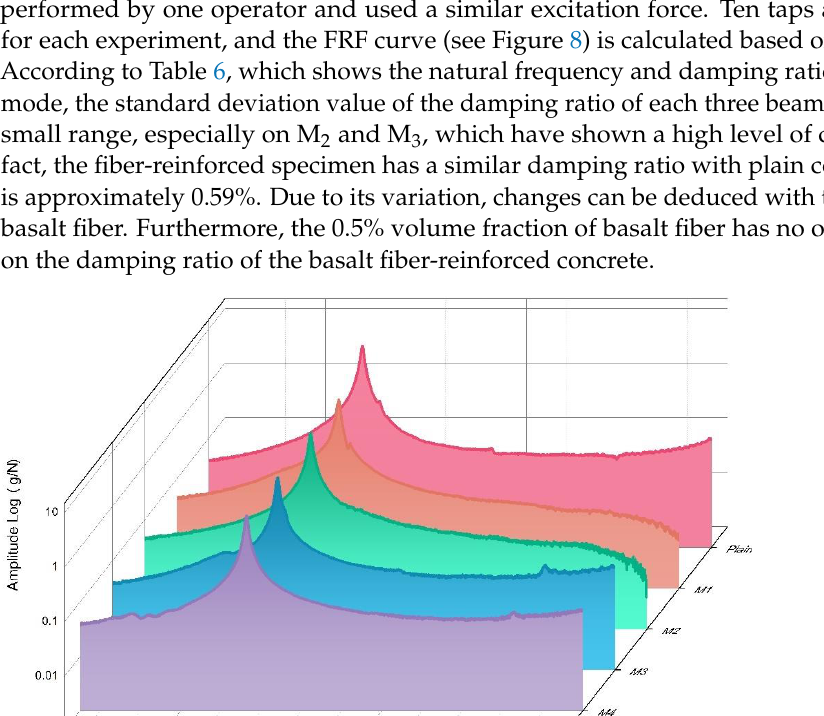
Figure 7. The post-crack of the concrete specimen after the bending test by contrast (left upper is M0, right upper is M1, left bottom is M2 and right bottom is M3).